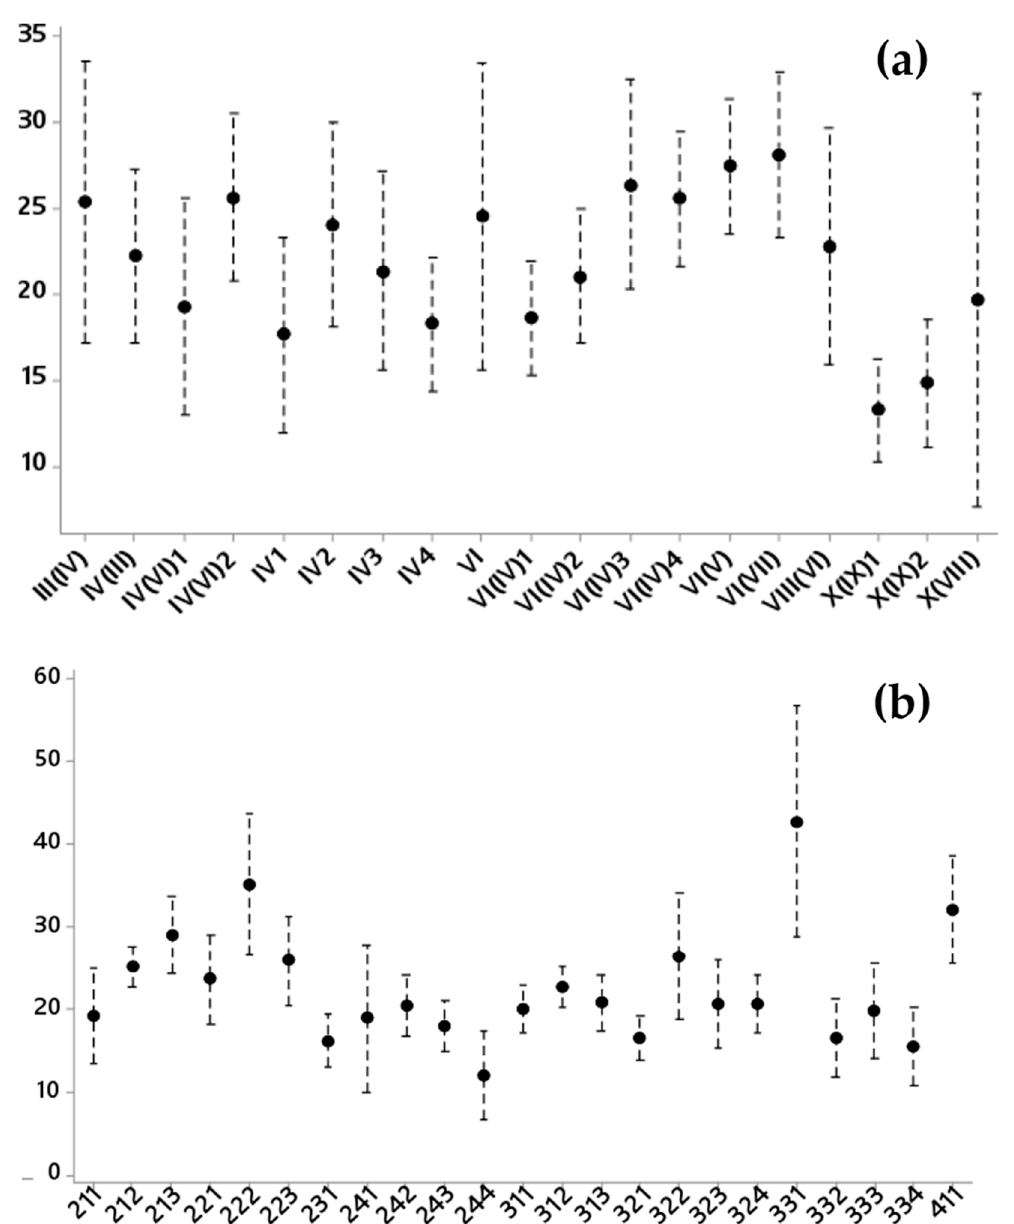
Figure 6. Interval plots (95% confidence interval (CI)) from the variance analyses. The x -axis labels are the Allué phytoclimatic regions ( a ) and the CORINE Land-Cover code; ( b ) the y -axis shows the percentage of significant ( p < 0.1) trend pixels.